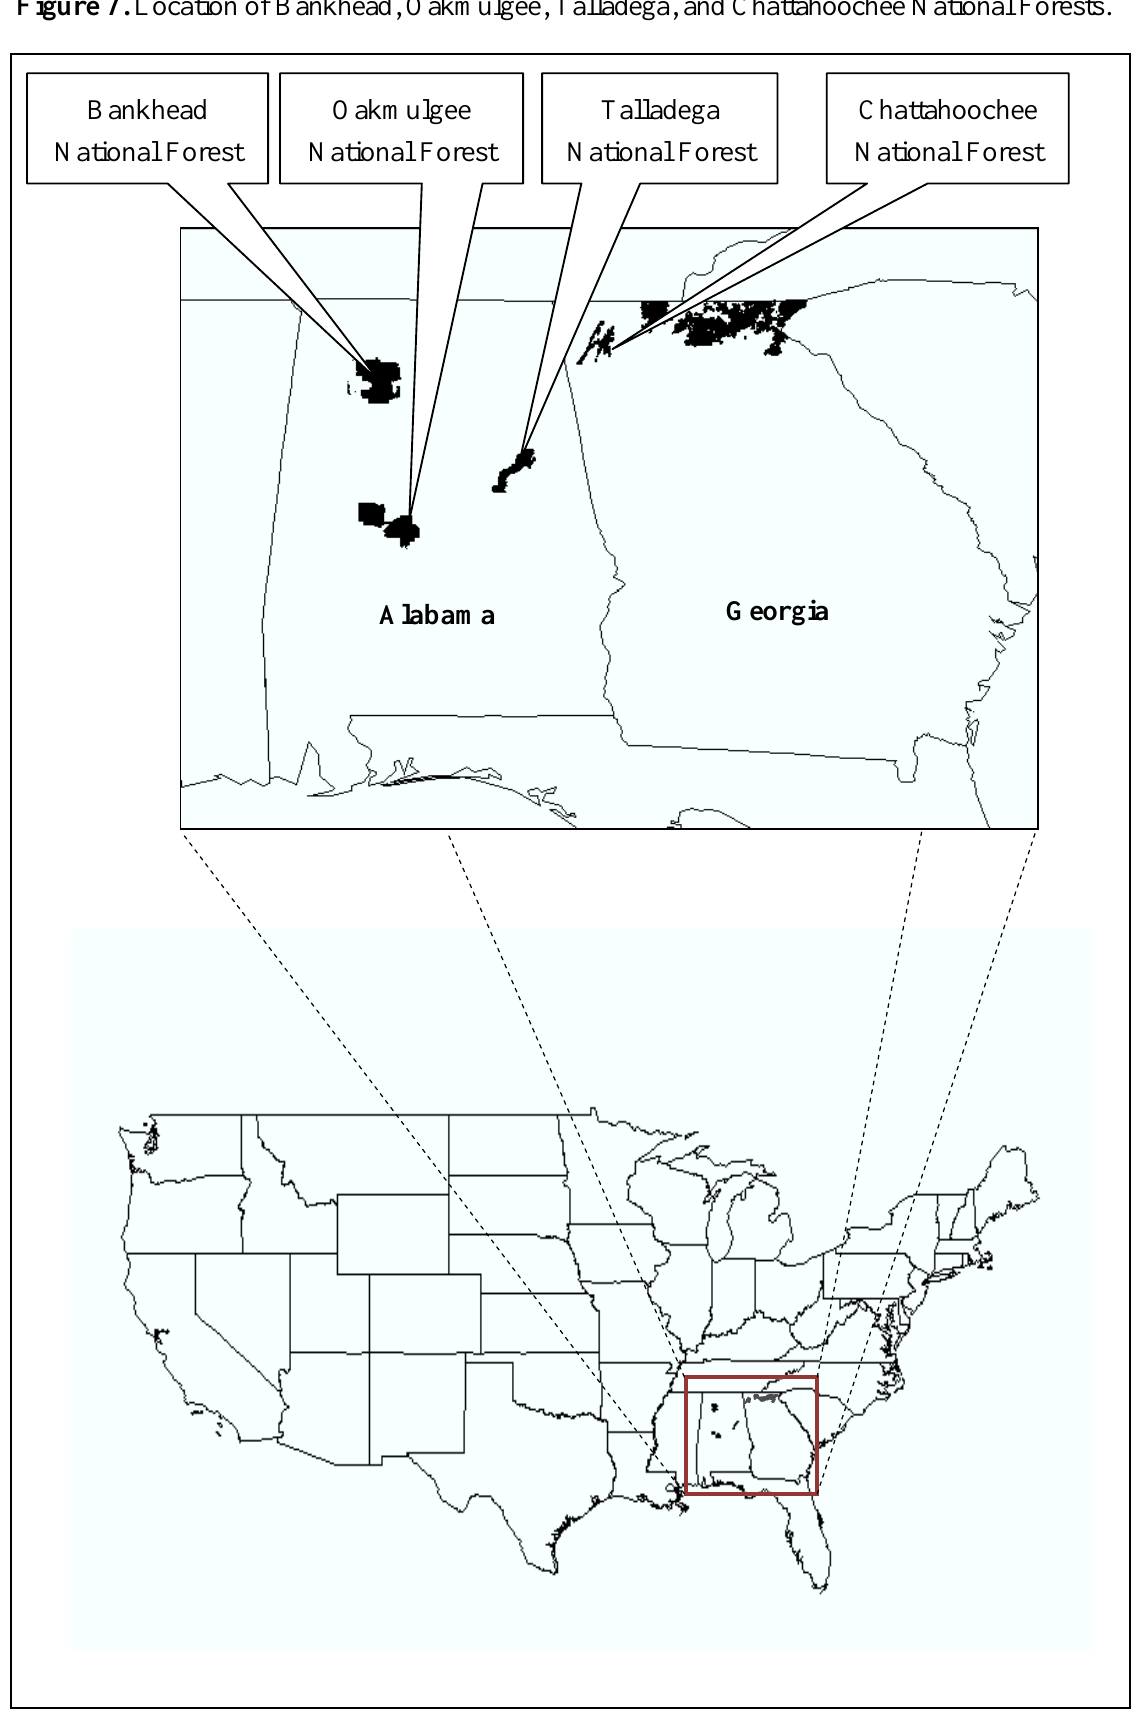
Figure 7. Location of Bankhead, Oakmulgee, Talladega, and Chattahoochee National